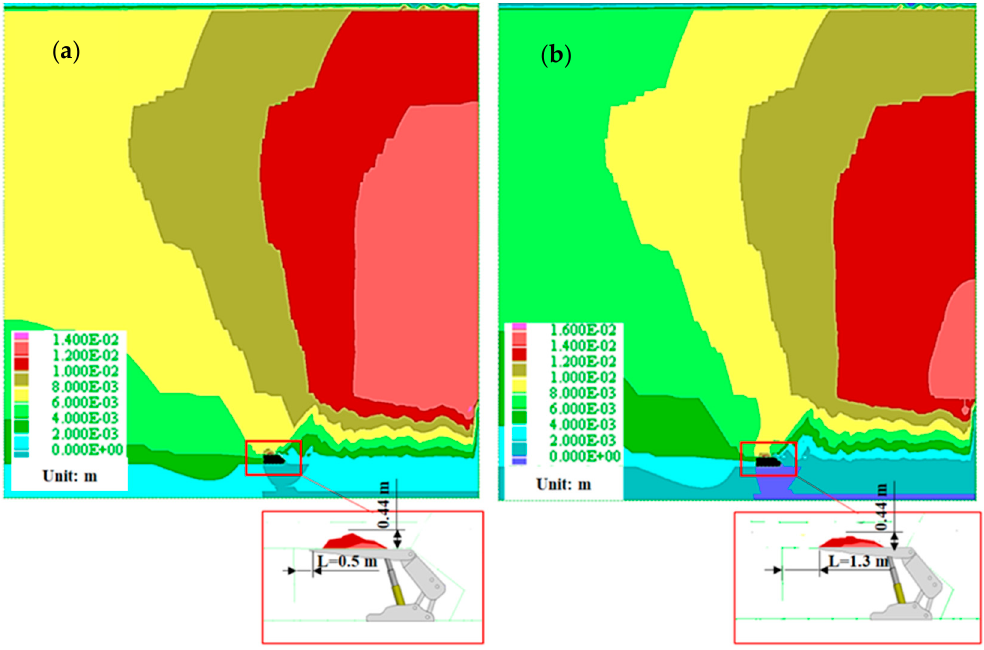
Figure 14. Vertical displacements in the rock mass model for the considered variant II, where: ( a ) before the web cut, ( b ) after the web cut.